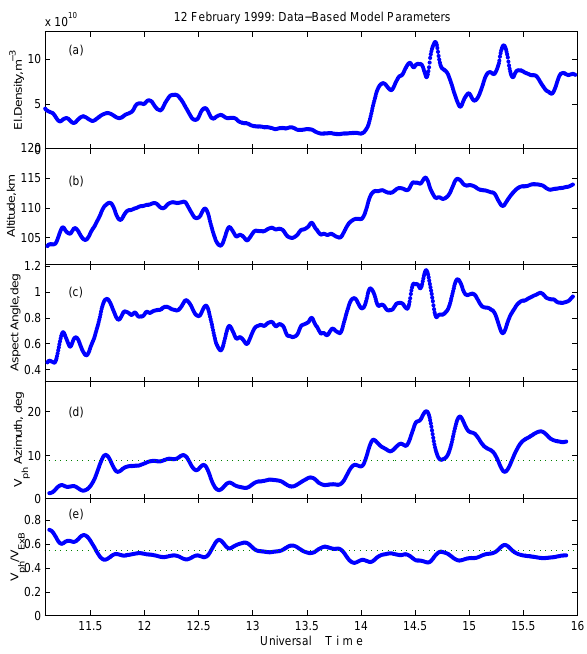
Fig. 5. The OOFA modelling: (a) the effective electron density seen by a radar, (b) the effective backscatter altitude, (c) the effec- tive aspect angle, (d) the clockwise azimuth offset of the largest irregularity phase velocity V ph with respect to the E × B azimuth and (e) the predicted | V ph | / | E × B | velocity ratio. Dotted lines in panels (d) and (e) are their eye-adjusted expected